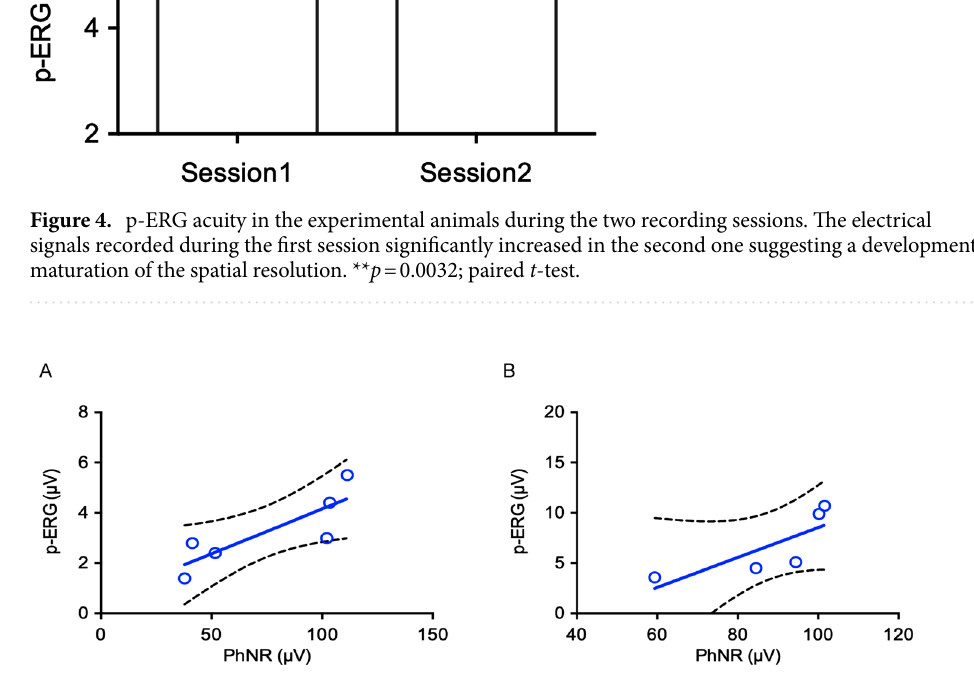
Figure 5. Linear regression analysis showing that p-ERG occurrence is positively correlated with the amplitude of the PhNR. The Pearson’s correlation coefficient shows a positive correlation between p-ERGs (1.552 cpd) and PhNRs during the first electrophysiological session ( p = 0.0379). A not significant trend was observed ( p = 0.1146) during the second session. Sample size: ( A ) n = 6, first session; ( B ) n = 5, second